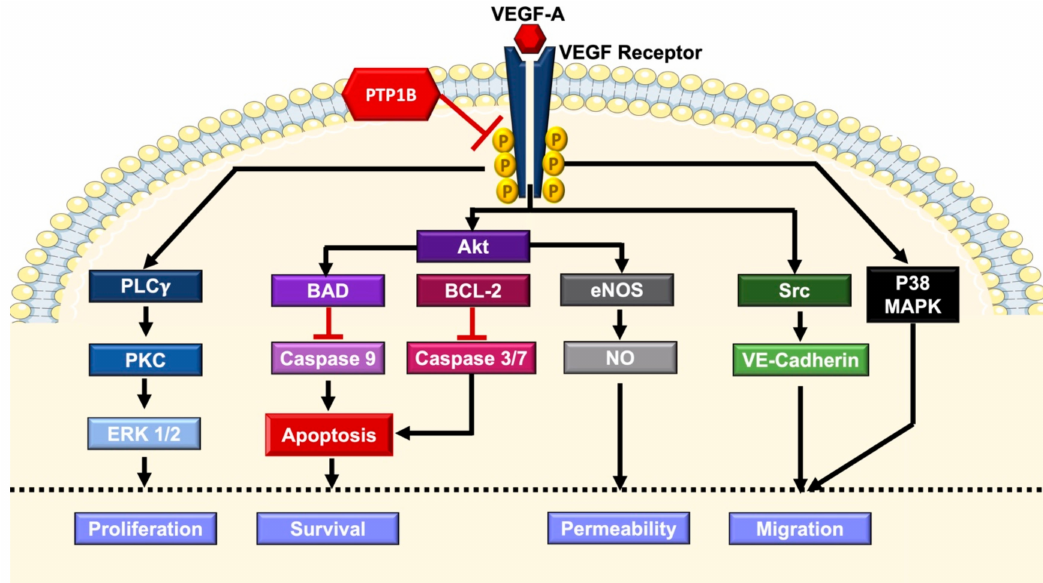
Figure 5. Vascular endothelial growth factor (VEGF) signaling. Binding of VEGF-A to its receptor induces the receptor’s intrinsic tyrosine kinase, which induces autophosphorylation initiating the downstream signaling cascade. The downstream e ff ectors include, PLC γ / PKC / ERK 1 / 2, PI3-K / Akt and p38 MAPK, which induce endothelial cell proliferation, survival and migration, respectively. The negative regulatory actions of PTP1B are indicated. BCL-2, B-cell lymphoma 2; BAD, BCL-2 agonist of cell death; eNOS, endothelial NO synthase; PI3-K, Phosphatidylinositol-4,5-bisphosphate 3-kinase; PLC γ , phosphoinositide phospholipase C γ ; PKC, Protein kinase C; ERK, Extracellular signal-regulated kinases; MAPK, mitogen-activated protein